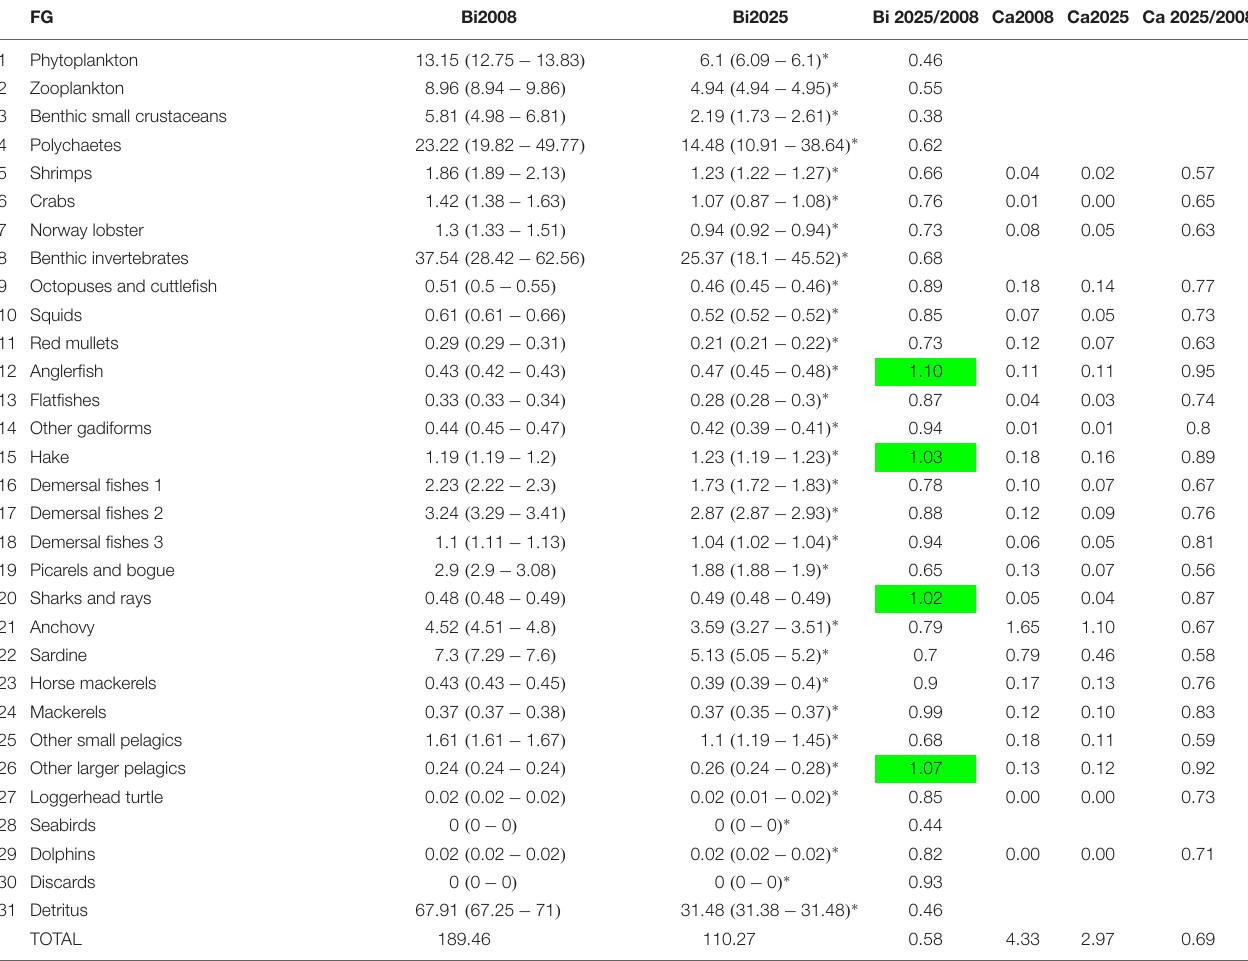
TABLE 6 | Ecosim simulation results for Pagasitikos Gulf for the scenario 0: business-as-usual. FG Bi2008 Bi2025 Bi 2025/2008 Ca2008 Ca2025 Ca